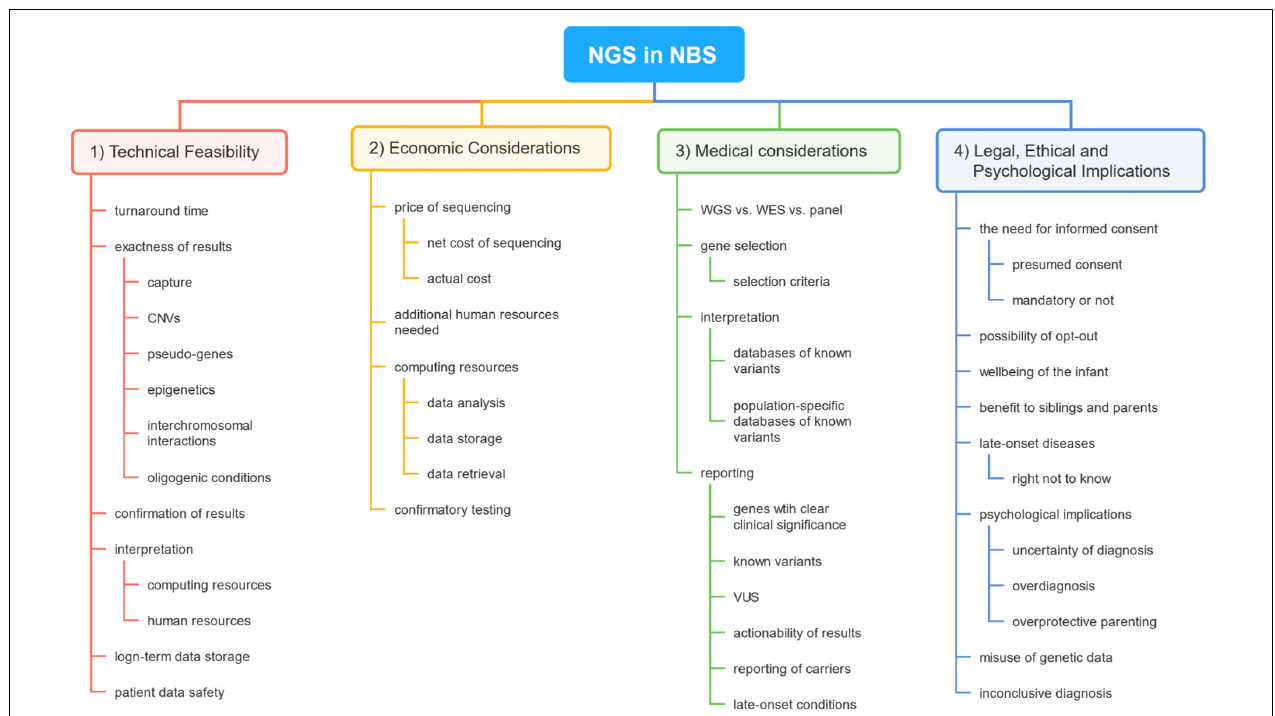
FIGURE 1 | A brief outline of topics covered in this review. The first section covers concerns regarding the basic technical feasibility of the use of next-generation sequencing (NGS) technology in newborn screening (NBS). The second section reveals the main factors impacting the cost of the use of such technology in NBS. The third section deals with medical problems the use of NGS would raise in NBS. The final sections engage in discussing legal, ethical, and psychological problems concerning NGS in the setting of